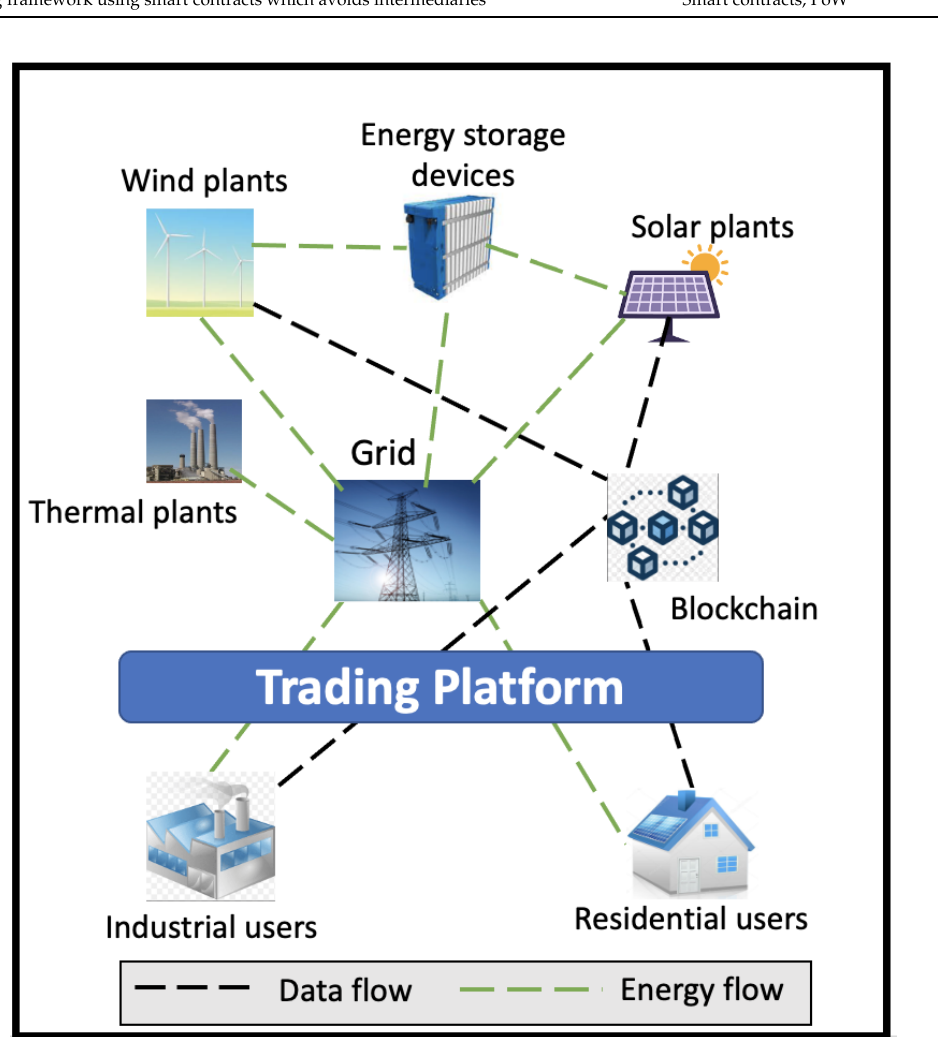
Figure 10. Model of energy trading using